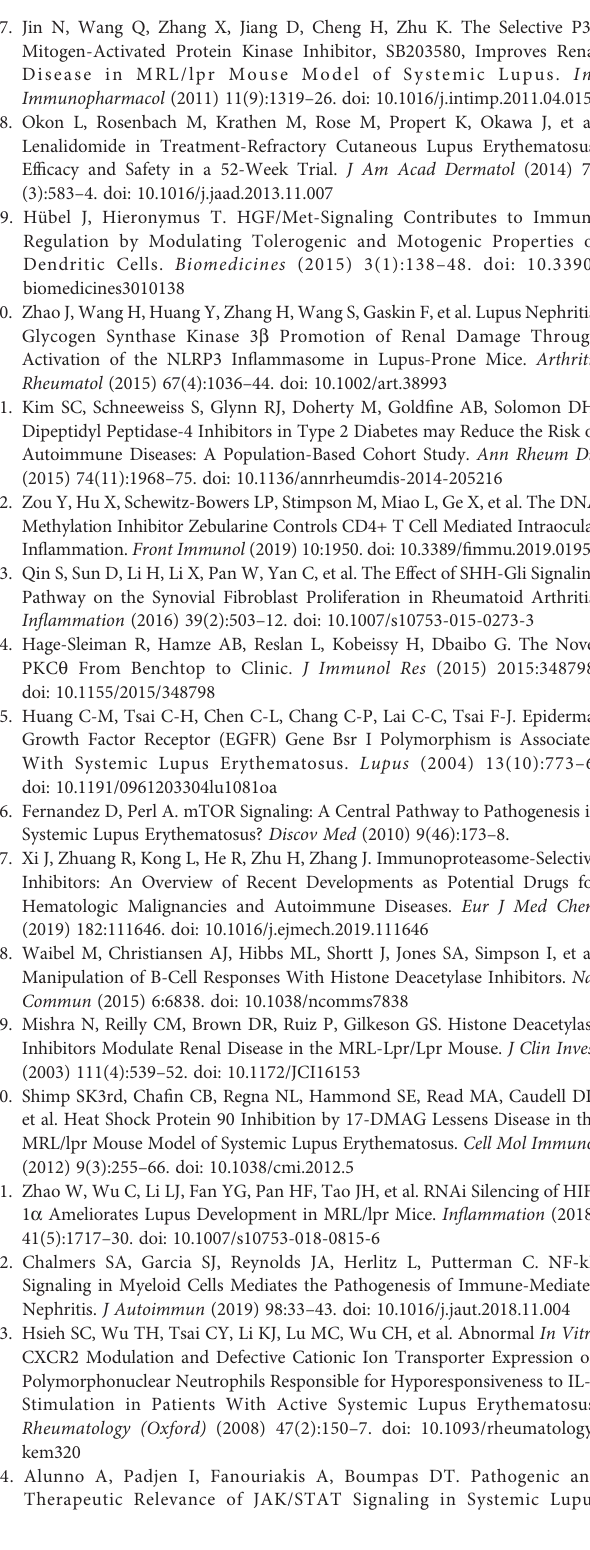
Supplementary Table 14 | Ranking of the compounds derived from the CLUE platform, through the CoDReS platform. This analysis was performed for SLE patients ’ molecular endotypes separately.